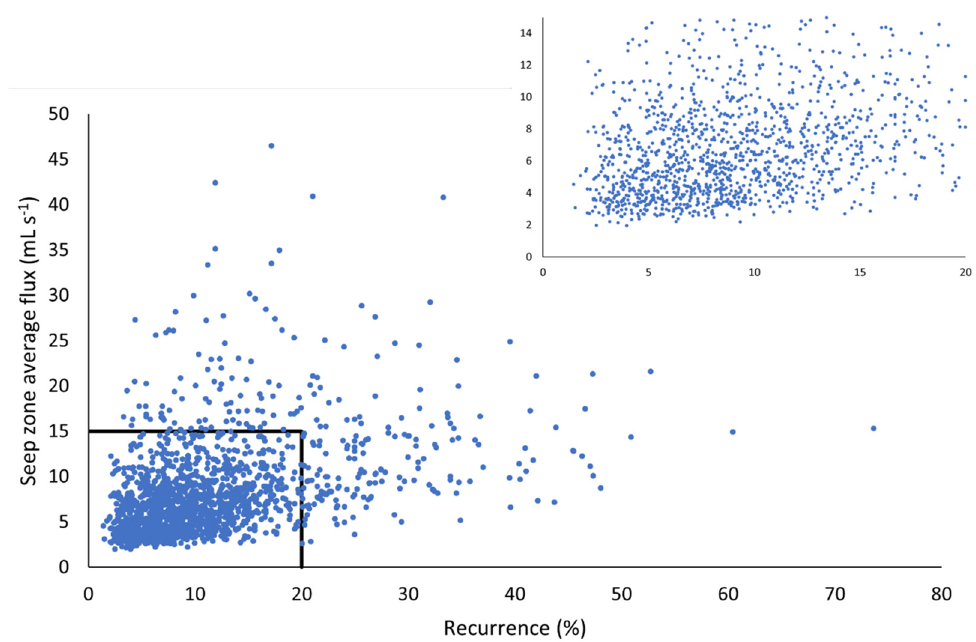
Figure 8. Comparison of recurrence rate and average flux of seep zones. Inset enlarged to show lack of relationship or correlation between recurrence rate and average flux.